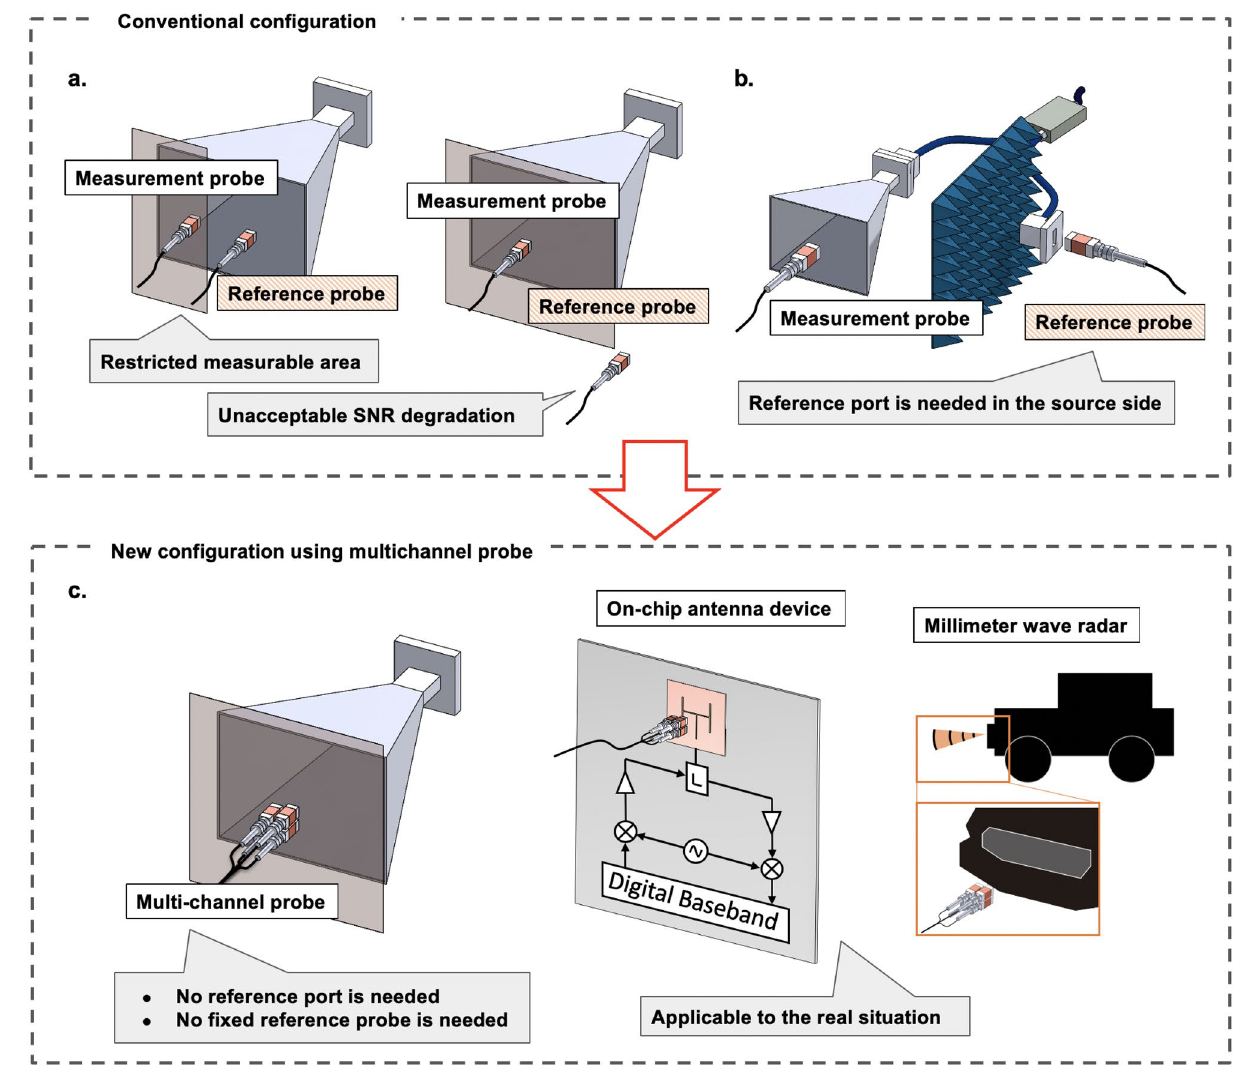
Figure 1. Schematic of the asynchronous measurement technique. ( a , b ) Two individual probes (single- channel probe and reference probe) are used in the conventional technique. The reference probe placed on the measurement plane restricts the moveable area of the measurement probe. To increase the measurable area, the reference probe should be set at the edge of the measurement plane; however, this generally results in unacceptable signal-to-noise ratio (SNR) degradation of the reference probe. Therefore, a reference port is required on the source side. ( c ) One integrated multichannel electro-optic (EO) probe is used for the near-field measurements in the new technique, in which no fixed reference probe or reference port is